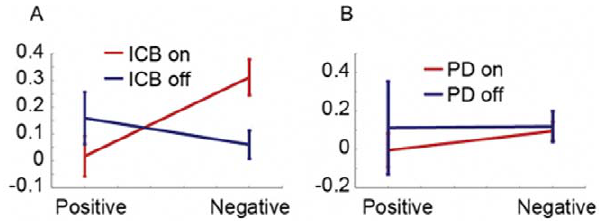
Figure 3. Learning from positive vs. negative feedback. Error bars show 1 s.e.m. A. Parameter values from the Bayesian model in PD + ICBs. B. Parameter values in PDs.